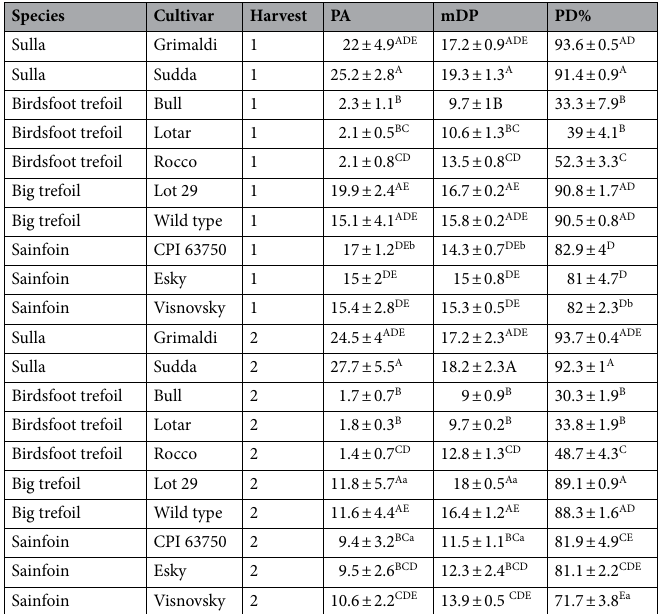
Table 2. Proanthocyanidin (PA) concentration and the structural traits of the PA containing species evaluated in the trial. PA, proanthocyanidin concentration (g/kg DM); mDP, mean degree of polymerisation; PD%, prodelphinidin percentage in PA. Values identify mean concentration of the measured parameters. Within a column significant differences ( P < 0.05) between the different cultivars for each harvest is represented by different uppercase letters and the significant differences within the harvests for each cultivar ( P < 0.05) is represented by different lower-case